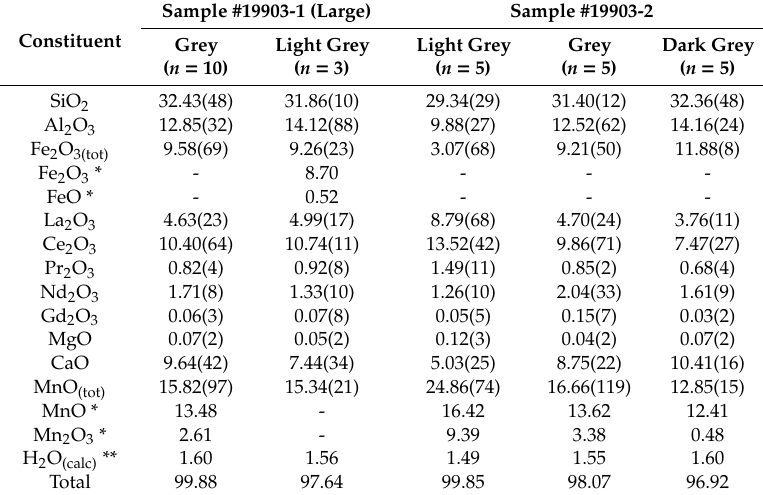
Table 2. Chemical composition (in wt %) of ferriakasakaite-(Ce) and coexisting epidote group minerals in samples #19903-1 and 19903-2.